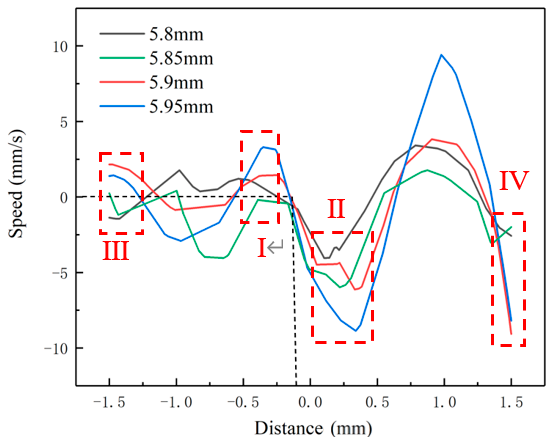
Figure 10. Velocity distribution in the y-direction in Figure 5 (1000 rpm, 120 mm/min, 5.8 mm pin length).